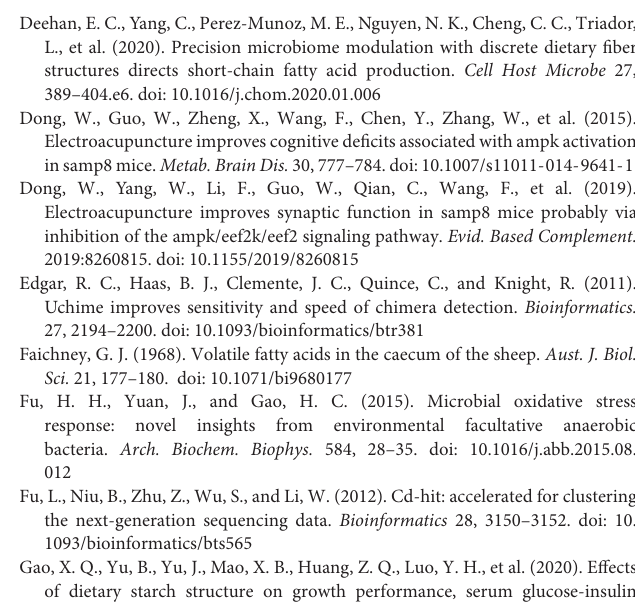
Supplementary Figure 1 | Effect of dietary RDS on the content of cellulose and amylose in the cecum digesta. Supplementary Figure 2 | A significant number of bacterial based on 16s rRNA sequence dataset between LRDS, MRDS, and HRDS